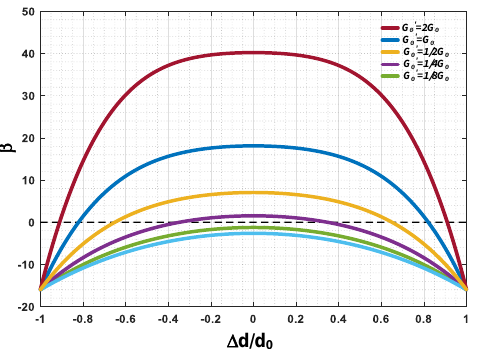
Figure 7. The value of β with the mismatch factor γ 0 at different loop gain values ( G 0 ).